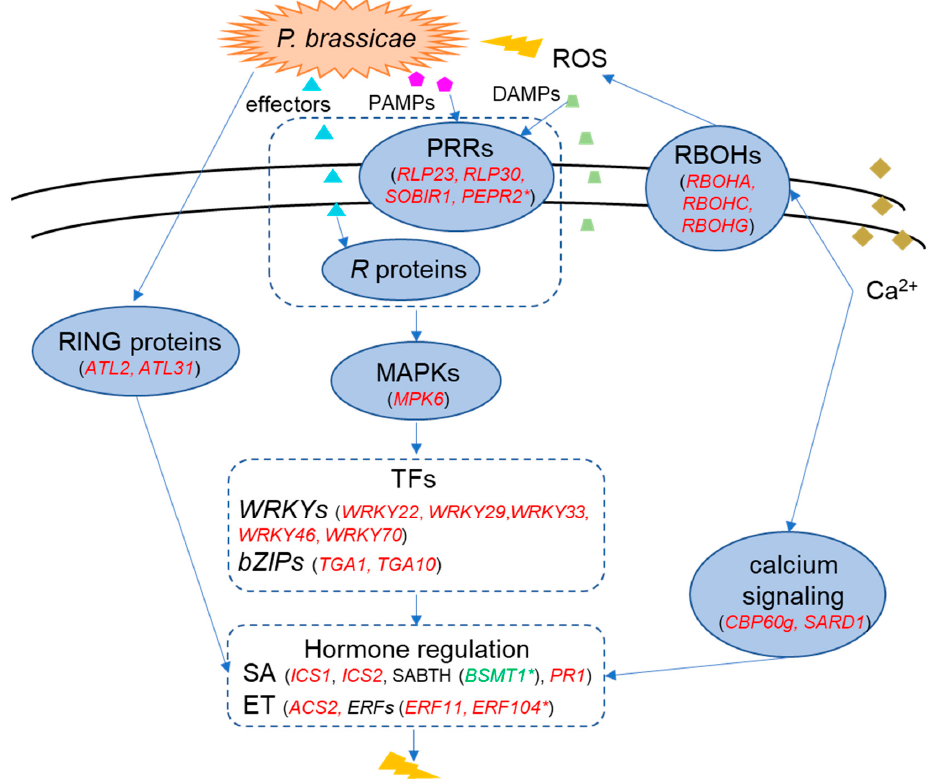
Figure 8. Model illustrating the major networks of the resistance response in the rutabaga ‘Wilhelmsburger’ to Plasmodiophora brassicae pathotype 3A. Important genes in each functional category are indicated in parentheses. Genes in red are upregulated, while those in green are downregulated in the resistant cultivar ‘Wilhelmsburger.’ Genes marked with an asterisk (*) were inversely regulated in the susceptible cultivar ‘Laurentian.’ Lightning bolt symbols indicate defense responses.